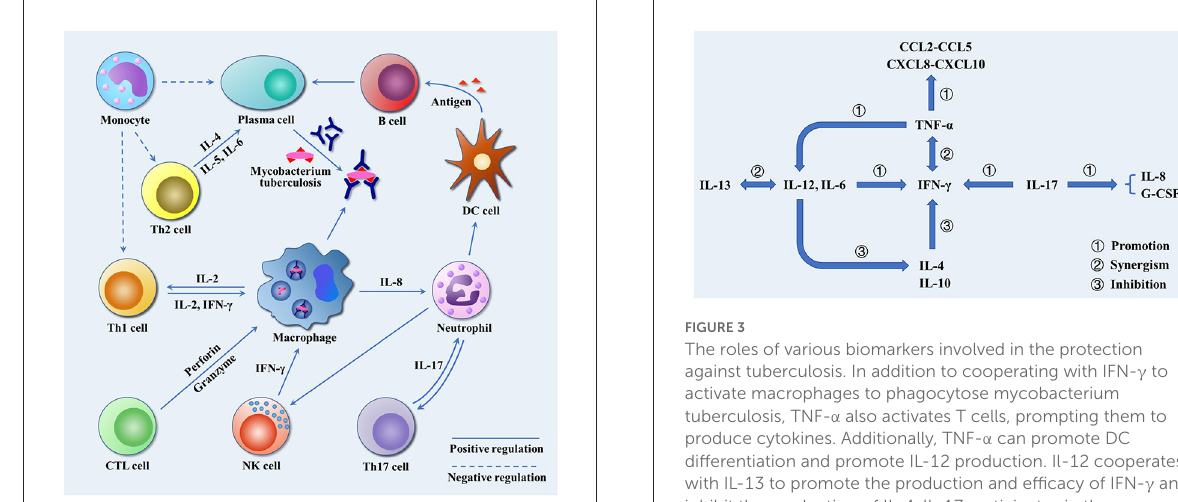
FIGURE2 The immune response to Mtb infection. Mtb travels through the respiratory tract to the lungs, where it is engulfed by alveolar macrophages. By inhibiting the fusion of phagosomes and lysosomes, and blocking the production of active nitrogen intermediates, it escapes the body’s immune killing and cause latent infection. Infected macrophages release IL-8 to attract neutrophils to the site of infection, and neutrophils in turn release chemokines to attract dendritic cells, NK cells and other immune cells to the site of infection to play an anti-tuberculosis role. IL-17 secreted by Th17 cells promote airway epithelial cells to produce IL-8 and G-CSF to attract more neutrophils, and participate in T cell-mediated IFN- γ and granuloma formation. NK cells release IFN- γ to promote Th1-type immune response. Dendritic cells, as professional antigen presenting cells, present Mtb antigen for B cells. B cells release antigen-specific antibodies to kill extracellular Mtb or Mtb released after macrophage death. Th2 cells release IL-4, IL-5 and IL-6 to assist the activation of B cells and promote the production of specific antibodies. In addition, macrophages release IL-2 to promote the proliferation and differentiation of Th1 cells, and Th1 cells secrete IL-2 and IFN- γ to reactivate infected macrophages. CTL cells differentiated from CD8 + T cells release perforin and granzyme to kill tuberculosis infected cells. Monocytes inhibit Th1 and Th2 by releasing TGF- β , and suppress the production of tuberculosis antibodies.